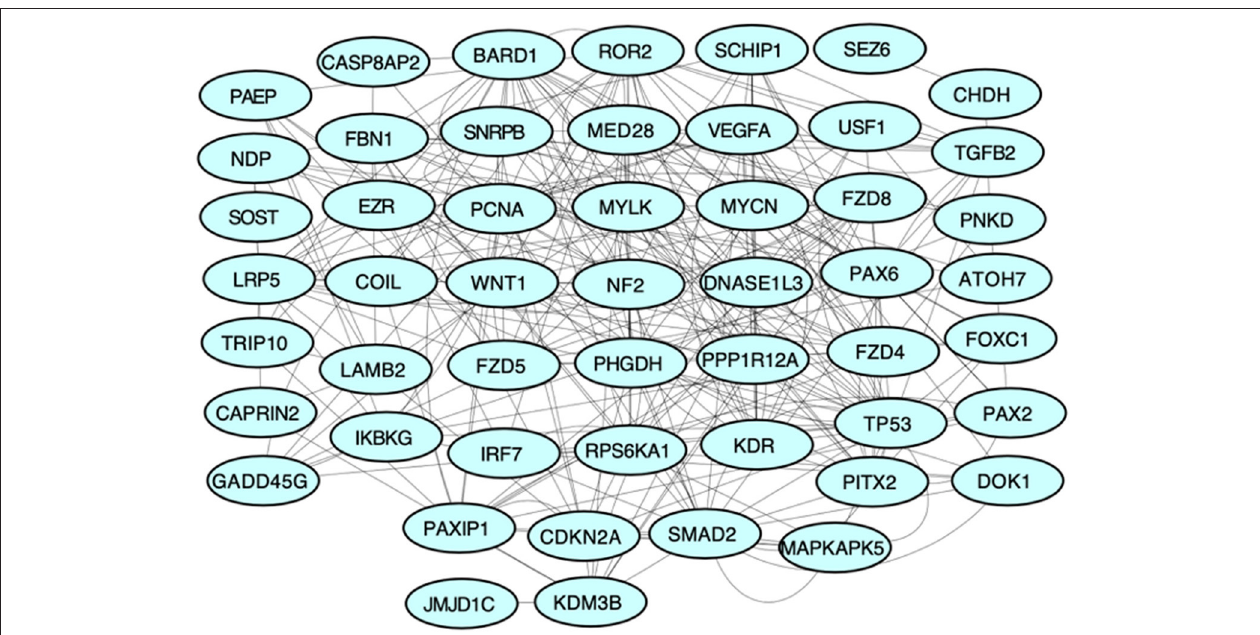
FIGURE 3 | Protein-protein interaction network of all TMGs related to PHPV. The network, genetic interactions, co-expression analysis, and pathways evaluated using Genemania, a Cytoscape plugin, are represented in the